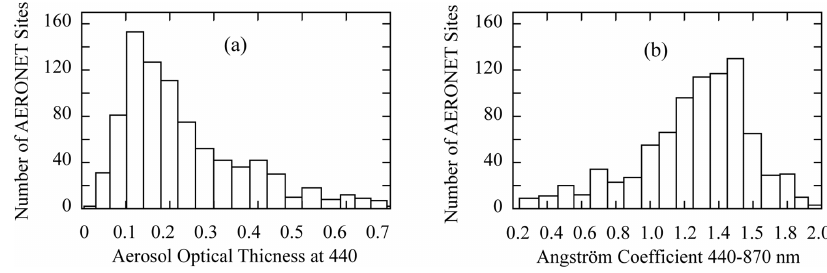
Figure 5. Aerosol optical thickness at 440nm frequency (a) and the Ångström coefficient frequency (b) .